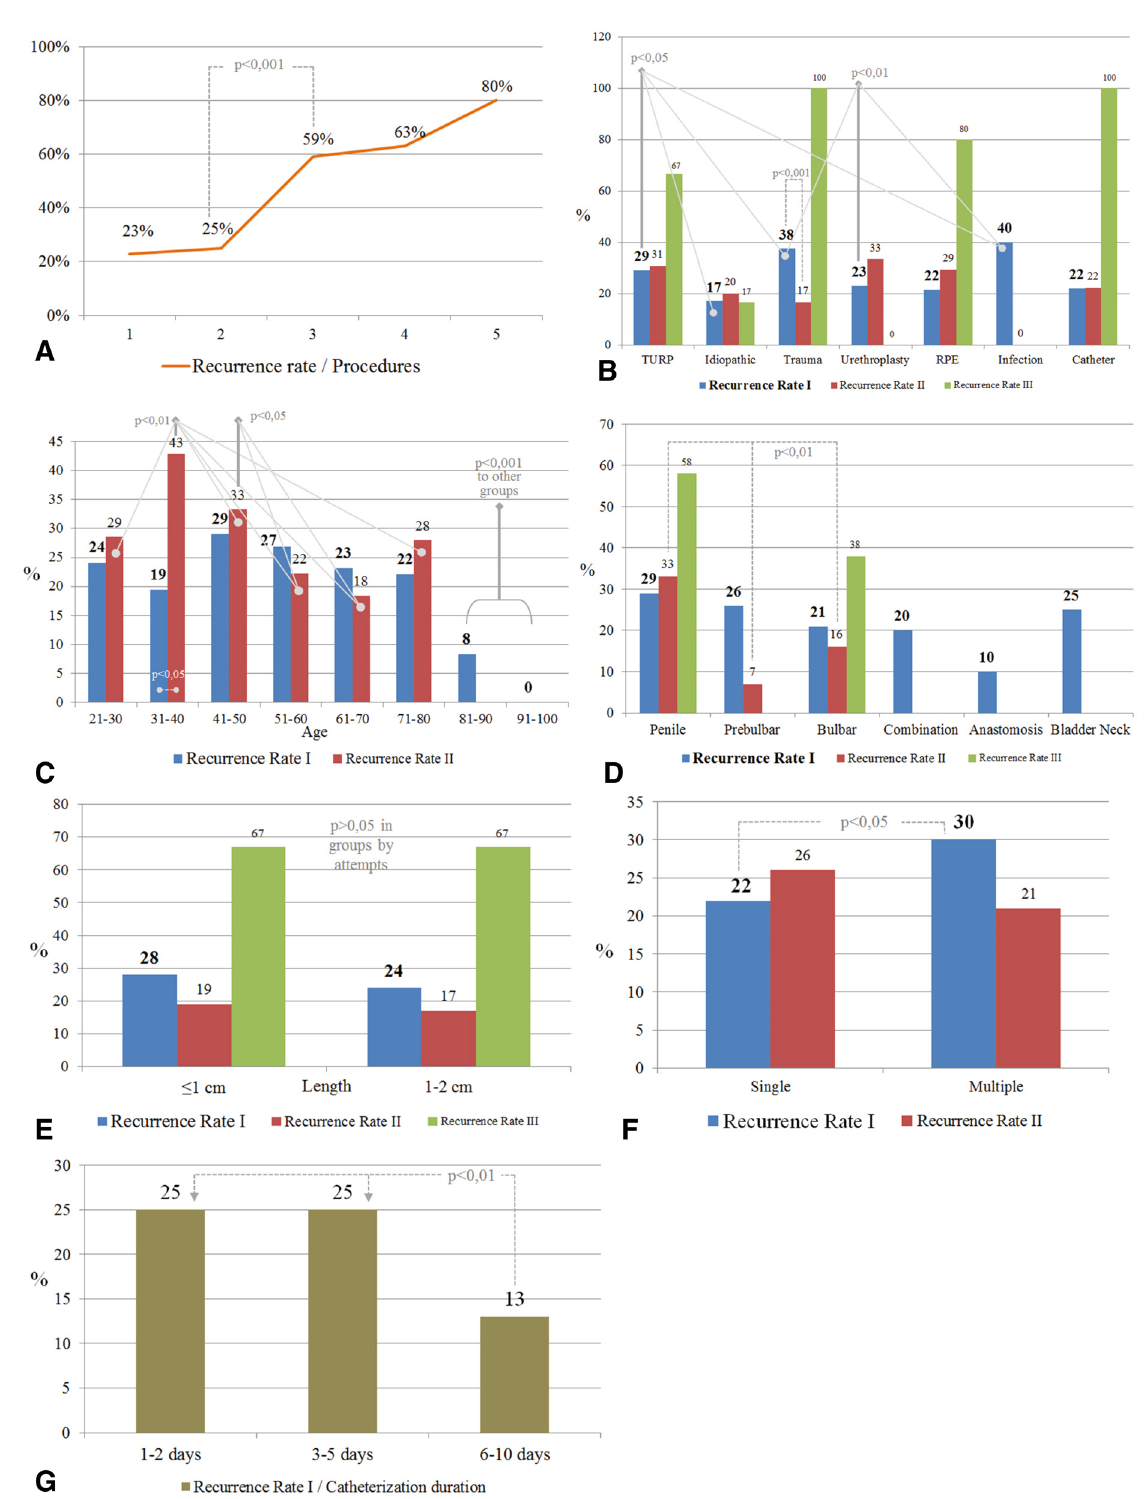
Figure 1. Recurrence rate after optical internal urethrotomy in patients with urethral stricture disease (Cohort II). A - Recurrence rate with respect to the number of urethrotomies in each patient. B - Recurrence rate with respect to the etiology after the 1 st , 2 nd and 3 rd urethrotomies. C - Recurrence rate with respect to the patient age after the 1 st and 2 nd urethrotomies. D - Recurrence rate with respect to the stricture location and number of consecutive procedures. E - Recurrence rate with respect to the stricture length ( ≤ 1 cm and 1–2 cm) and number of urethrotomies. F - Recurrence rate with respect to the number of consecutive strictures in each patient after the 1 st and 2 nd attempts. G - Recurrence rate with respect to the catheterization duration after the 1 st